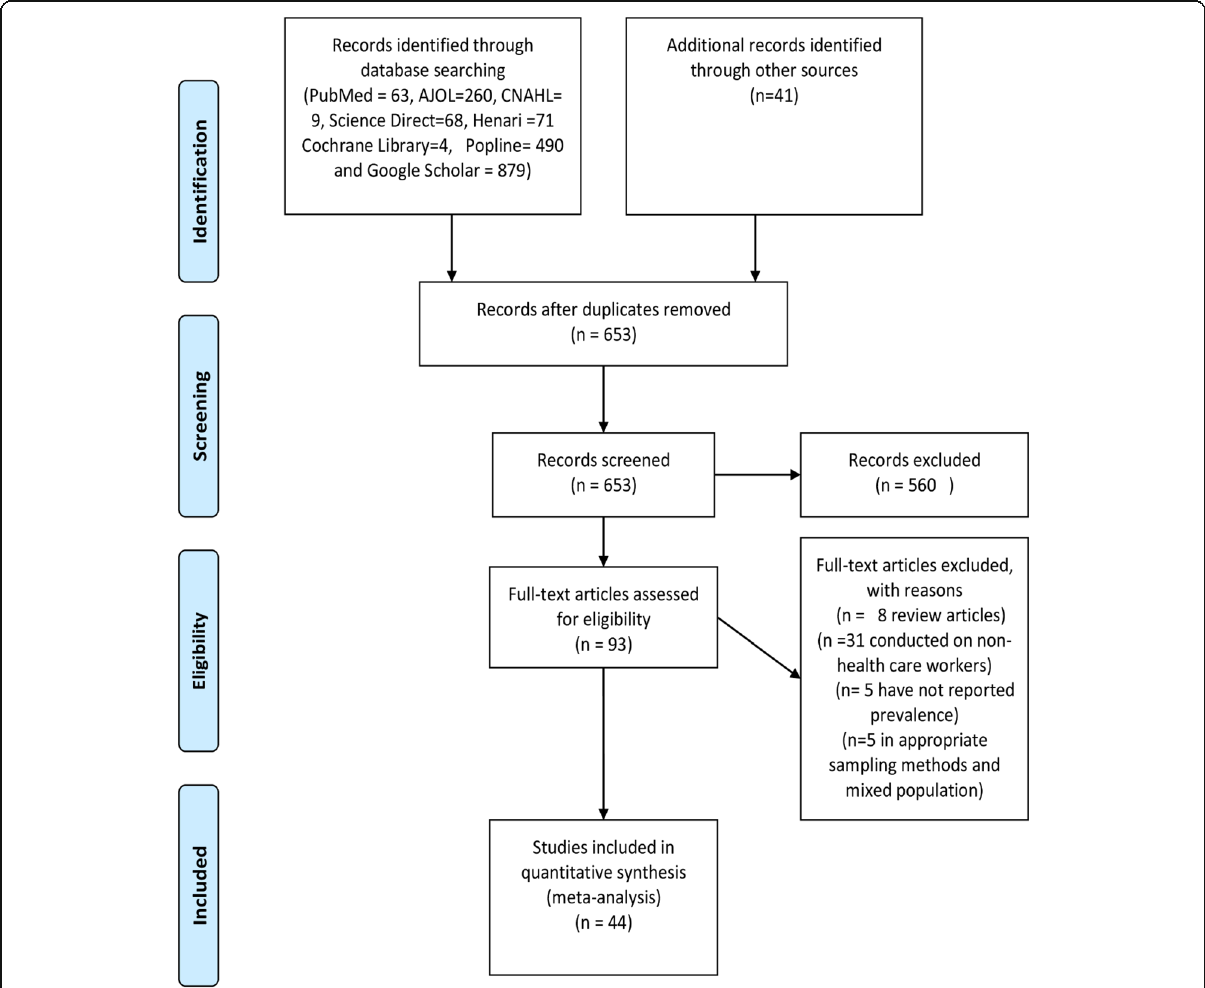
Fig. 1 Flow diagram of systemic review and meta-analysis on prevalence of hepatitis B and C among health care workers in Africa, 1989 –